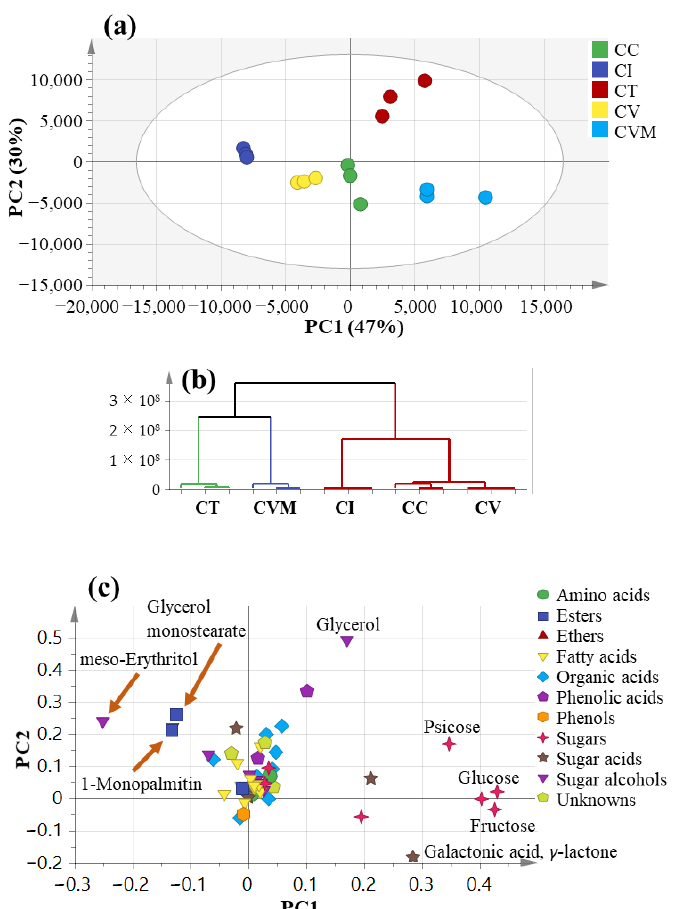
Figure 3. GC-MS principal component analyses of the different cinnamon taxa ( n = 3) ( a ) score plot of PC1 vs. PC2, ( b ) respective loading plot with contributing chemical classes, and ( c ) HCA plot. The metabolome clusters are placed in two-dimensional space at the distinct locations defined by two vectors of principal component PC1 = 47% and PC2 = 30%. CC: Cinnamomum cassia from Malaysia, CI: C. iners from Malaysia, CT: C. tamala from Pakistan, CV: C. verum from Pakistan, CVM : C. verum from